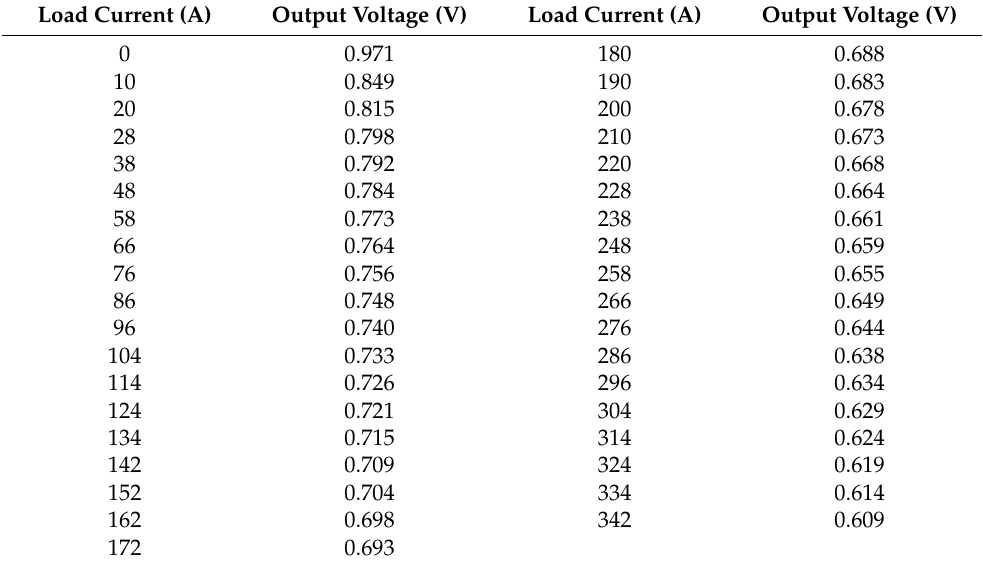
Table 5. HFC output voltage test data.